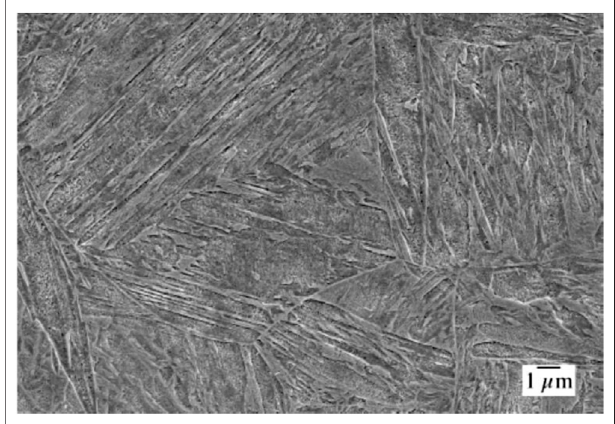
FIGURE 1 | Scanning electron micrograph of the as-quenched microstructure of the Fe-0.19 ° C-4.39 Mn steel (nital